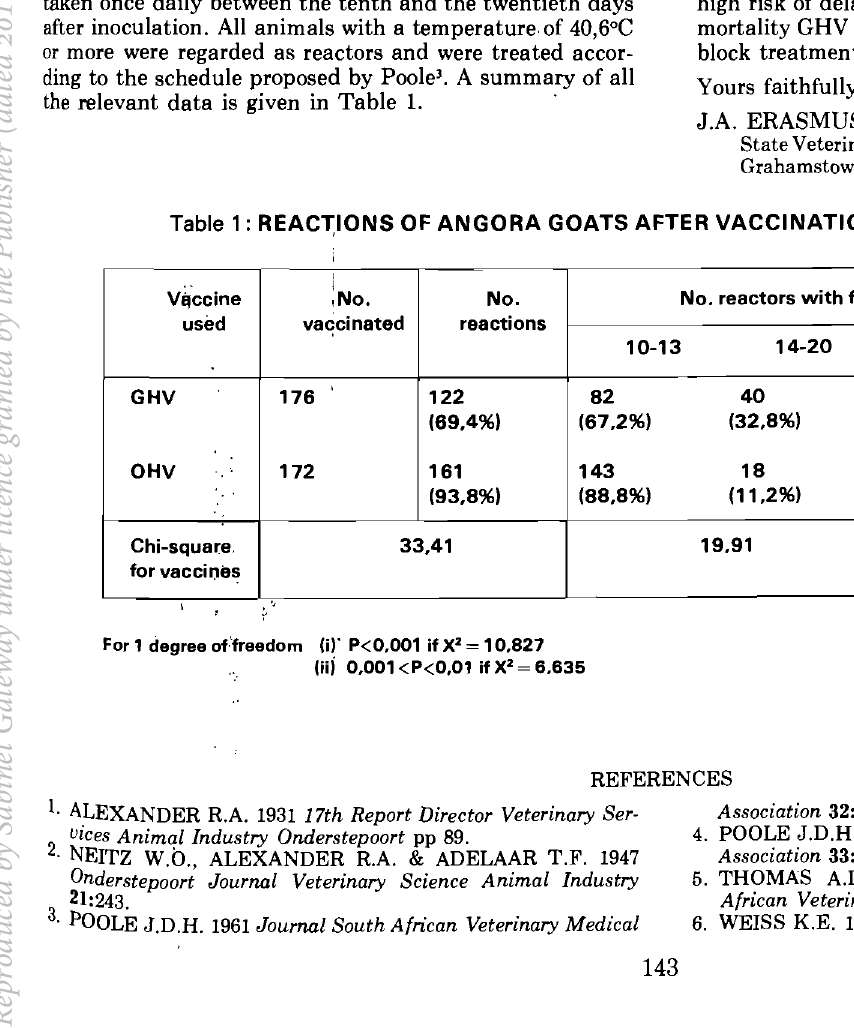
Table 1 : REAC~IONS OF ANGORA GOATS AFTER VACCINATION AGAINST